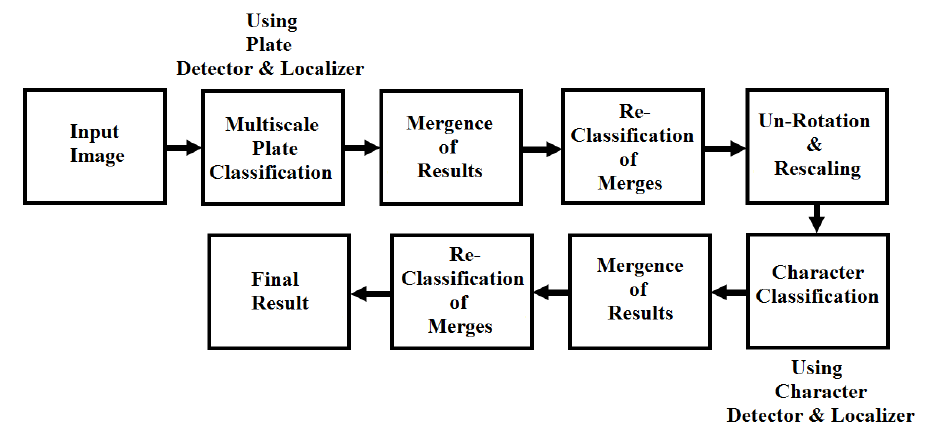
Figure 3. Flow of neural network-based automatic license plate recognition